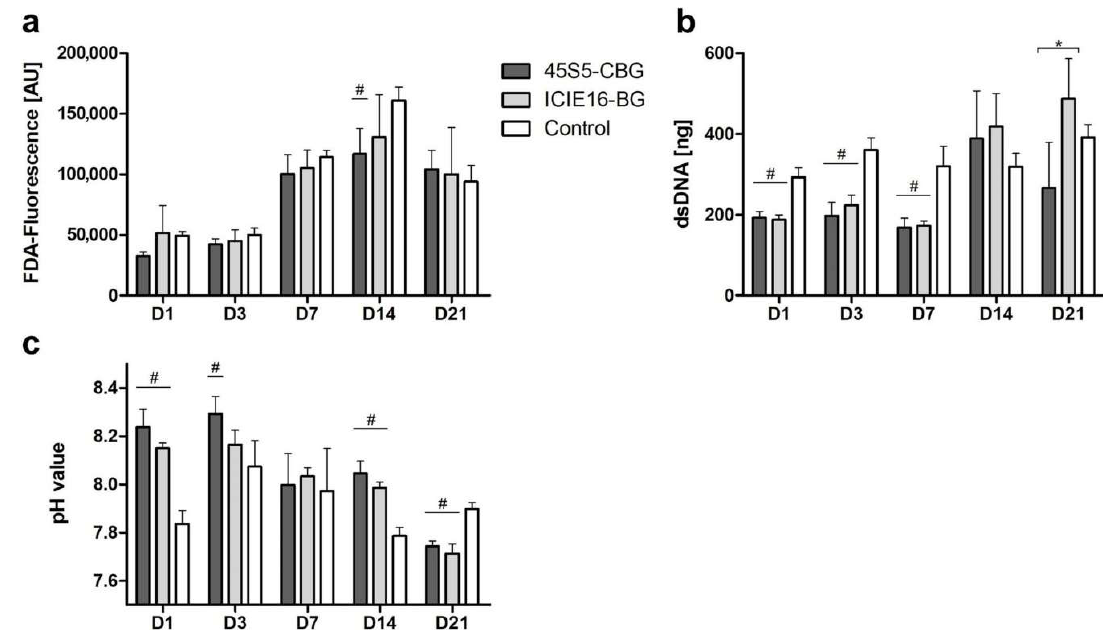
Figure 1. Quantification of cell viability ( a ), proliferation ( b ), and pH ( c ). Values are shown as means with standard deviation. # indicates significant difference to control group and * indicates significance between the bioactive glass (BG) groups being encompassed by brackets.